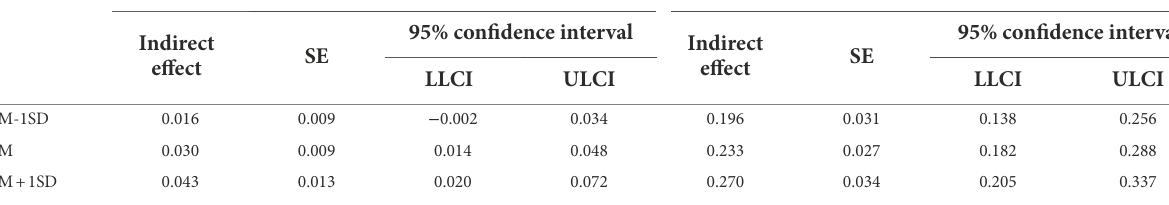
TABLE 5 Results of moderated mediating effect.